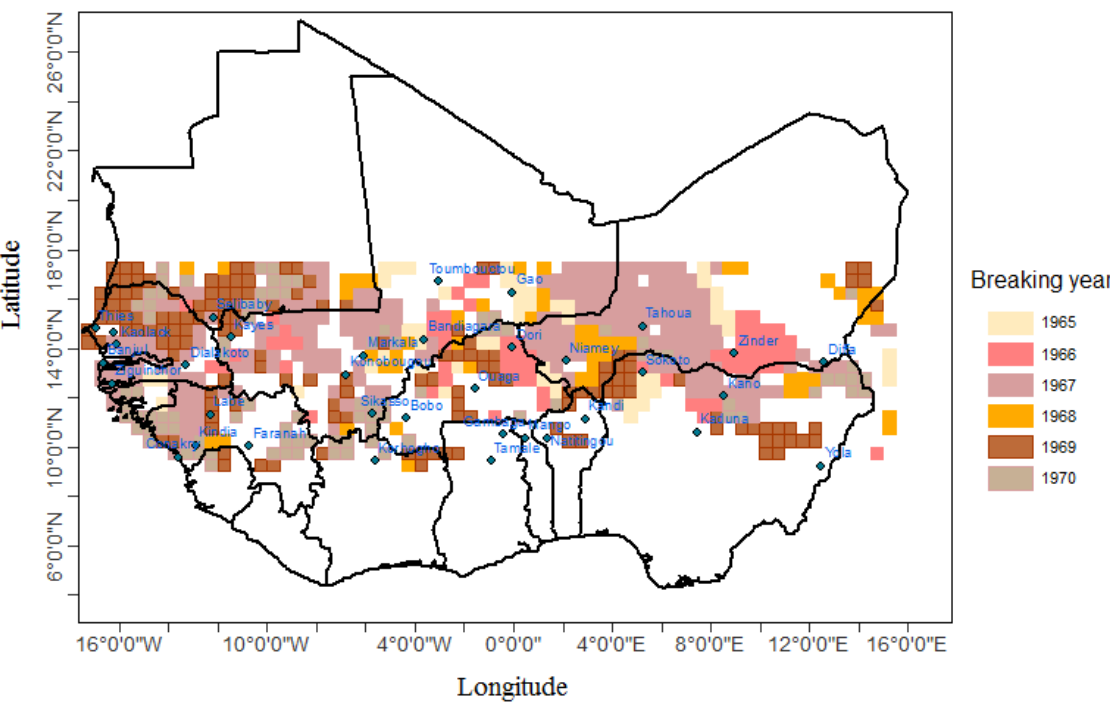
Figure 8. Geographical distribution of breaks during the 1966–1970 period from the CRU_1995 data.